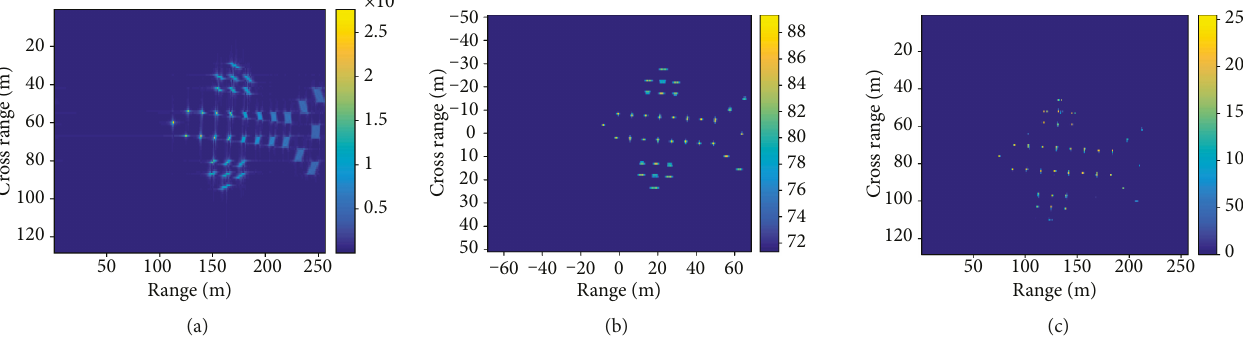
Figure 5: Imaging results with the target ’ s motion parameters P2. (a) RD algorithm. (b) Keystone transform. (c) The proposed method.